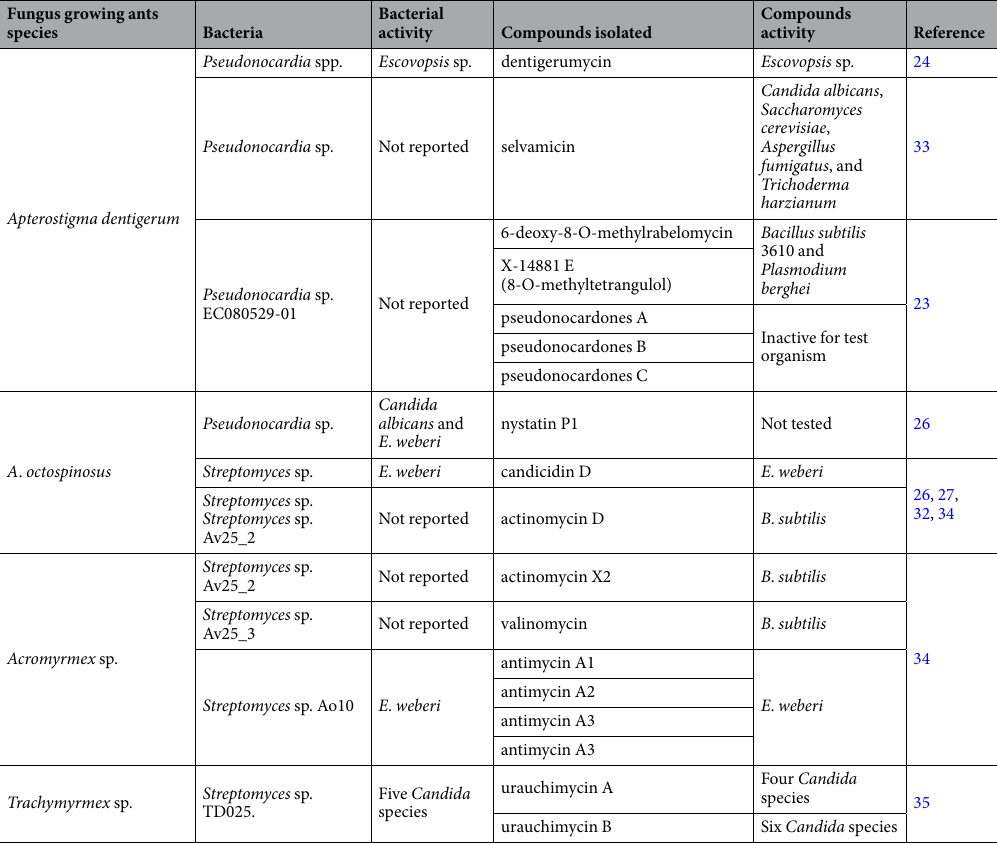
Table 1. Metabolites described for antibiotic producing bacteria associated to the fungus-growing ants. The table summarizes compounds that are produced by the bacteria associated with fungus growing ant’s species pointing out the activity against the fungal pathogen, Escovopsis